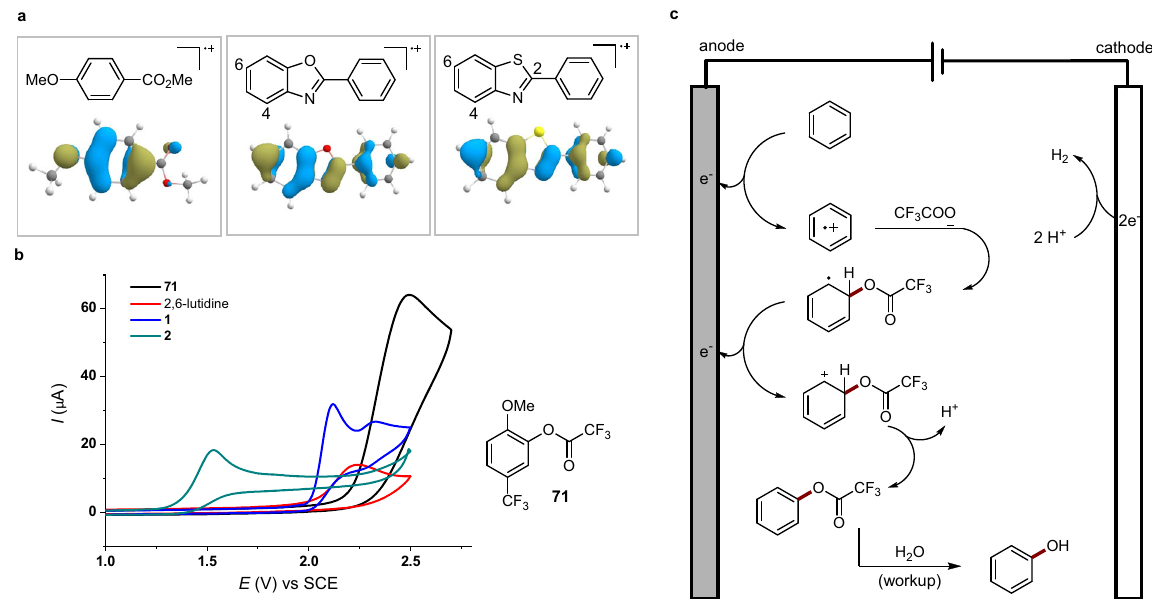
Fig. 5 Mechanistic studies and proposal. a Computed SOMO of radical cations at ROM062X/6-31G* level of theory. C, O, S, and H atoms are colored in grey, red, yellow, and white, respectively. The LUMOs are visualized by blue and dark yellow isosurfaces. b Cyclic voltammograms obtained in MeCN. c Mechanistic